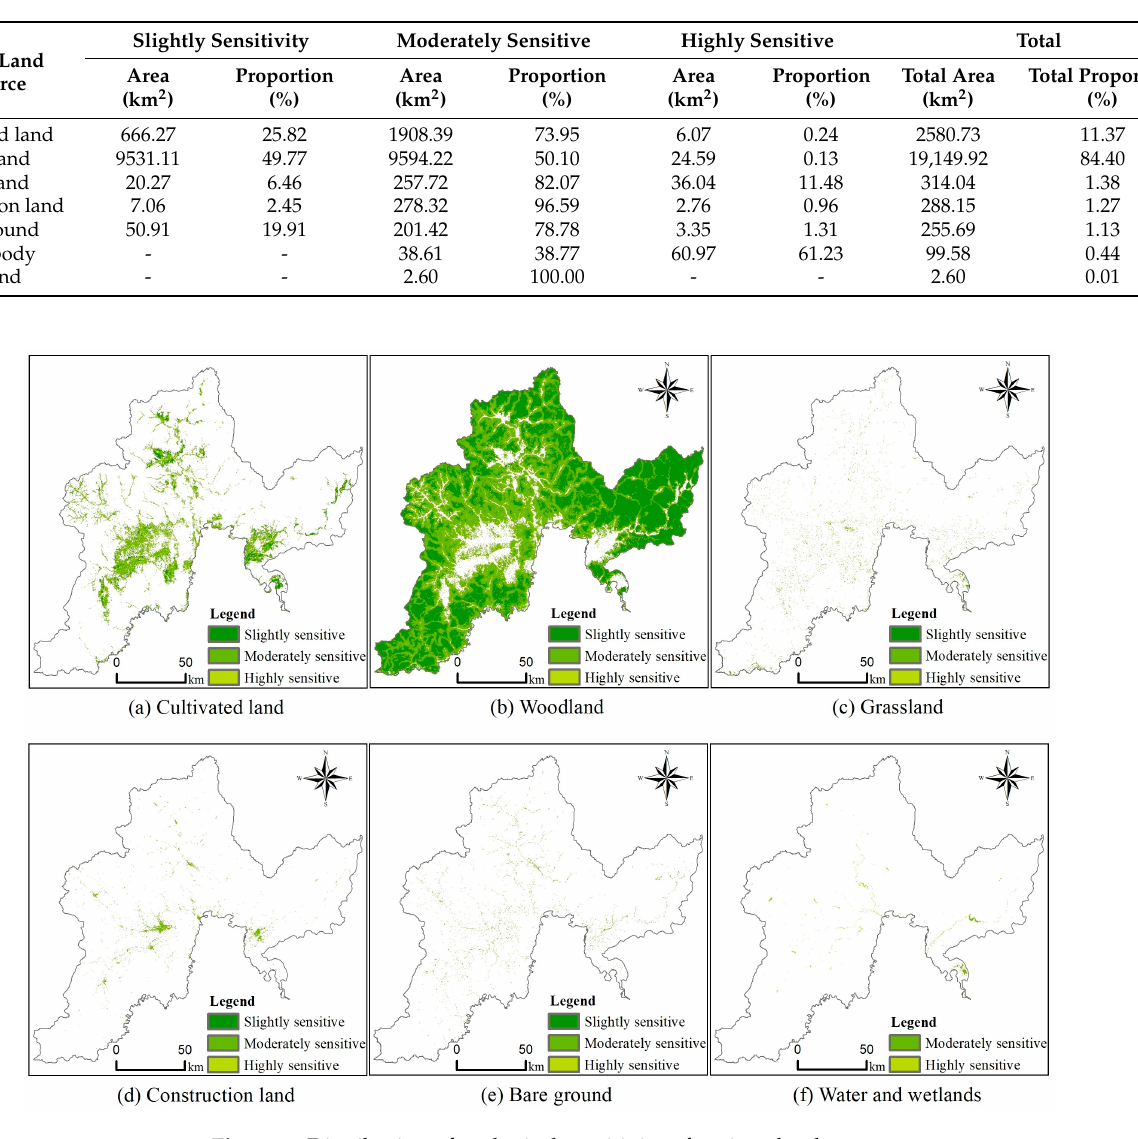
Figure 7. Distribution of ecological sensitivity of various land resource types.